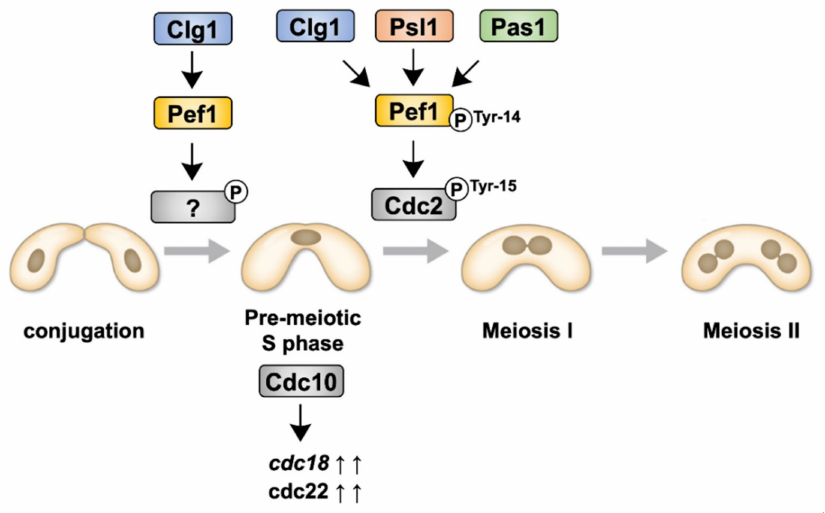
Figure 7. Illustration representing the signaling pathways of Pef1 and cyclins during